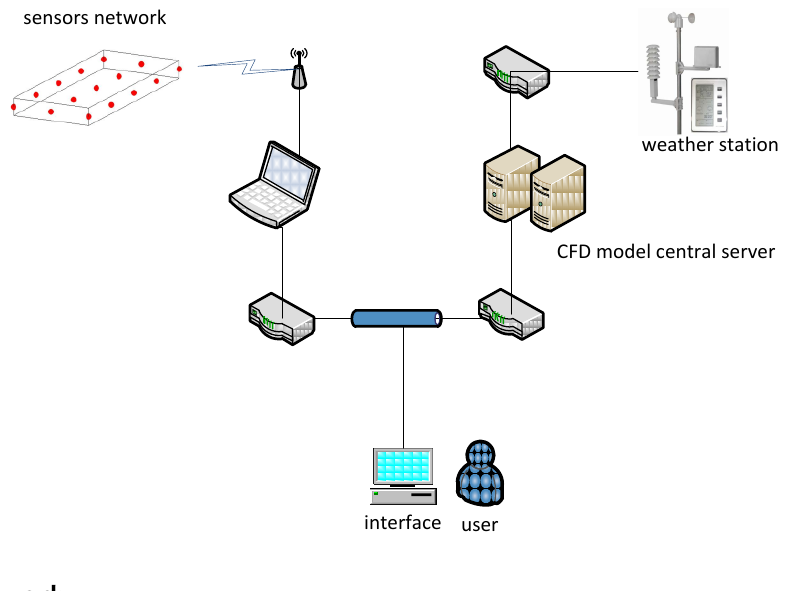
Figure 1. The basic physical components of the diagnostic